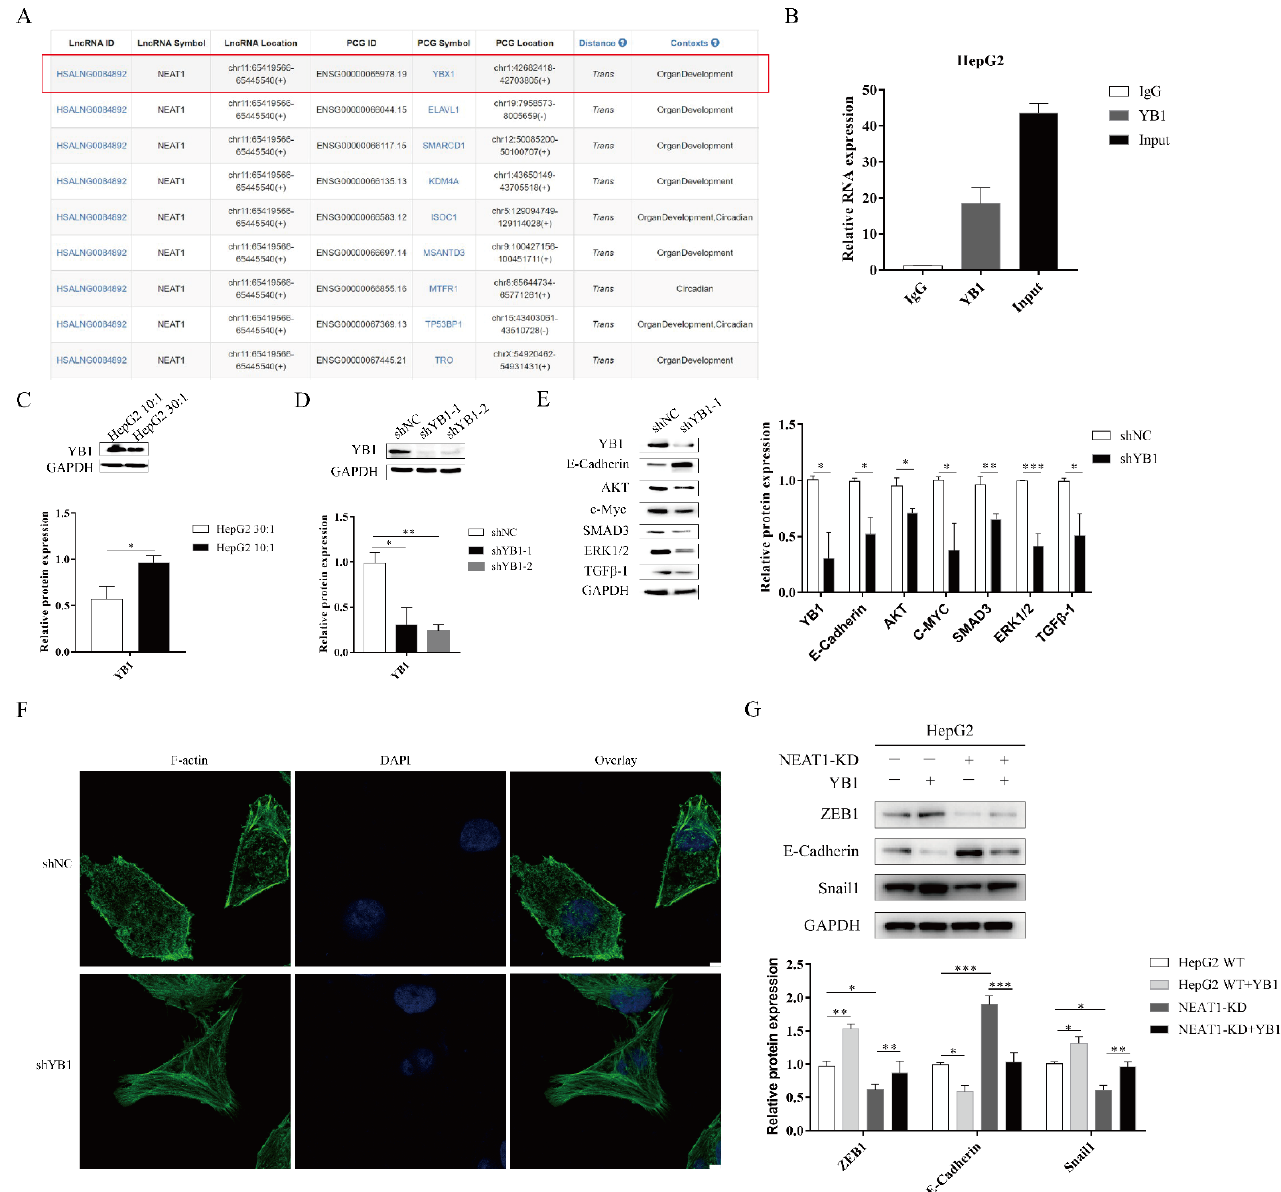
Figure 5. The lncRNA NEAT1 regulates the EMT process through YB1. ( A ) Analysis of the RNA binding proteins (RBPs) using an online database. We list relative score > 80% of RBP (YBX1). ( B ) The RNA immunoprecipitation experiment was performed using YB1 and IgG antibodies to probe HepG2 cell extracts, and the level of NEAT1 expression was determined using qPCR. ( C ) Effects of substrate stiffness on the expression of YB1 in HepG2 cells. HepG2 cells were cultured in 3D micropillars (10:1, 30:1) for 48 h. ( D , E ) The silencing efficiency of YB1 and downstream target in HepG2 cells were detected using WB. ( F ) HepG2 cells were treated after lentivirus transduction for 72 h. Phalloidin analysis of F-actin expression and localization by confocal microscope. (Scale bar: 5 μ m). ( G ) Effects of YB1 on the expression of EMT-associated protein in HepG2-KD and HepG2 cells. Transfection of YB1 plasmid in HepG2-KD and HepG2 cells for 72 h. Western blot analyzed the protein expressions of E-Cadherin, ZEB1, and Snail1. *, p < 0.05; **, p < 0.01; and ***, p < 0.001.